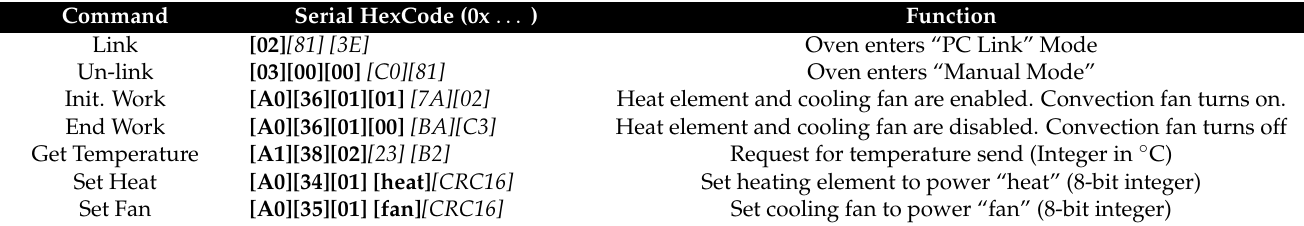
Table 1. The seven functions of PC-Link